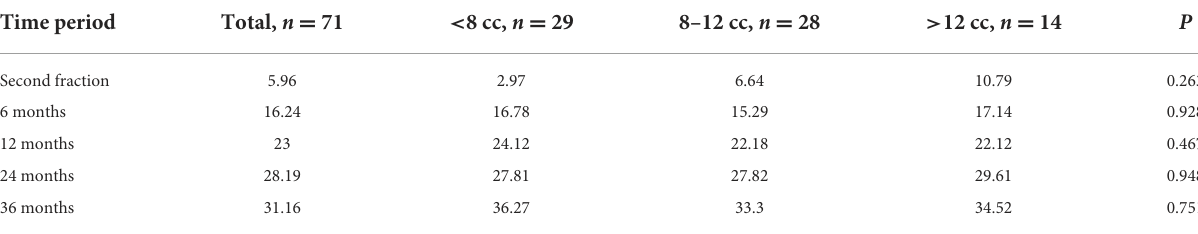
TABLE 2 Mean percentage reduction in volume for meningiomas with different initial volume after dose-staged Gamma Knife (%). Time period